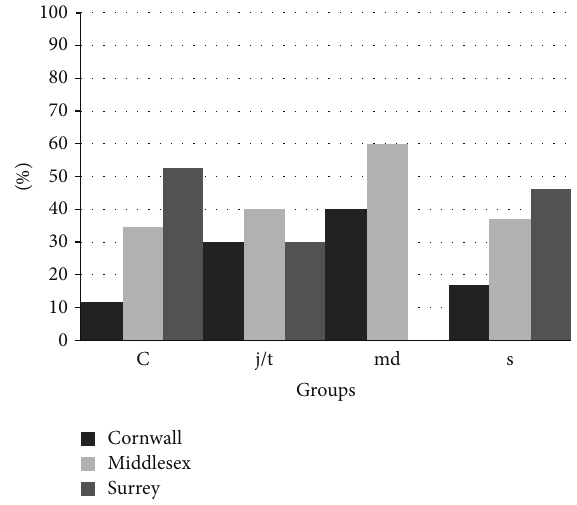
Figure 2: Place of birth of athletes and controls. County distribution of controls did not differ from the sprint and jump and throw athletes ( 𝑃 = 0.59 and 0.23) but differed from middle distance athletes (𝑃 < 0.0001) . The county distribution of middle distance athletesdifferedsignificantlyfromthatofsprintathletes (𝑃 < 0.001) .